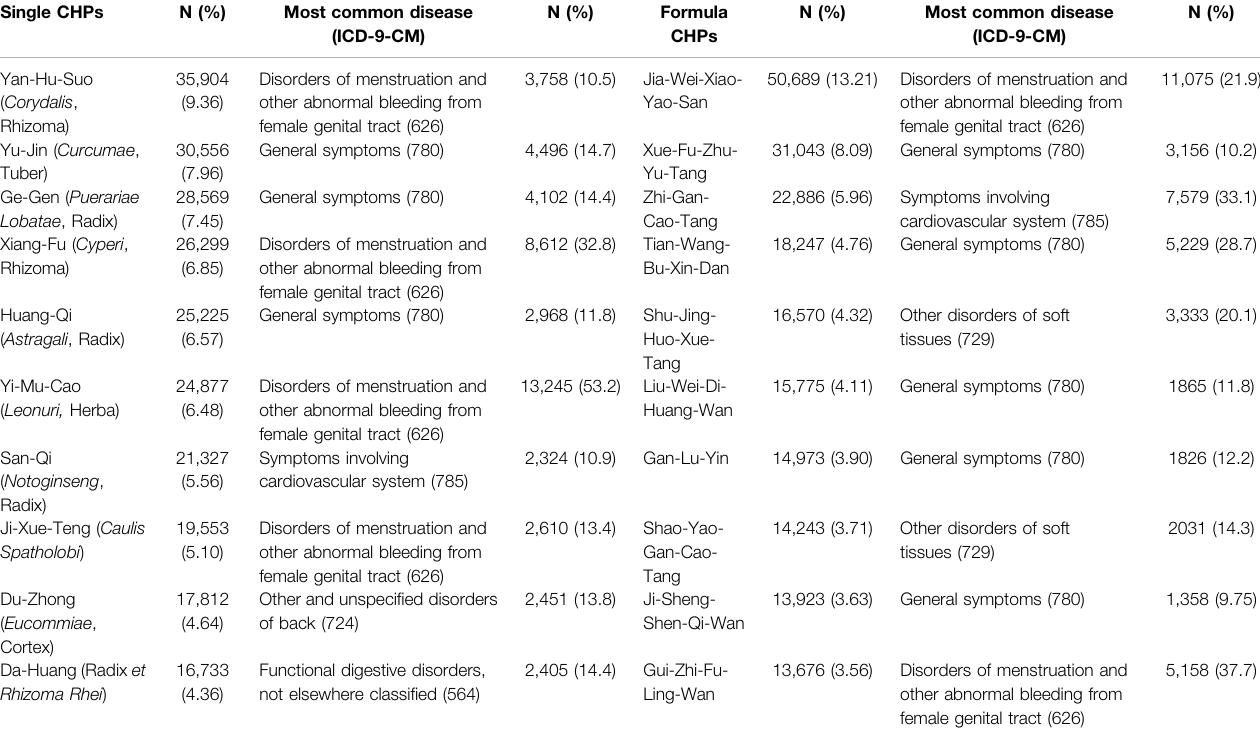
TABLE 5 | Top 10 single and formula CHPs prescribed with radix Salvia miltiorrhiza . Single